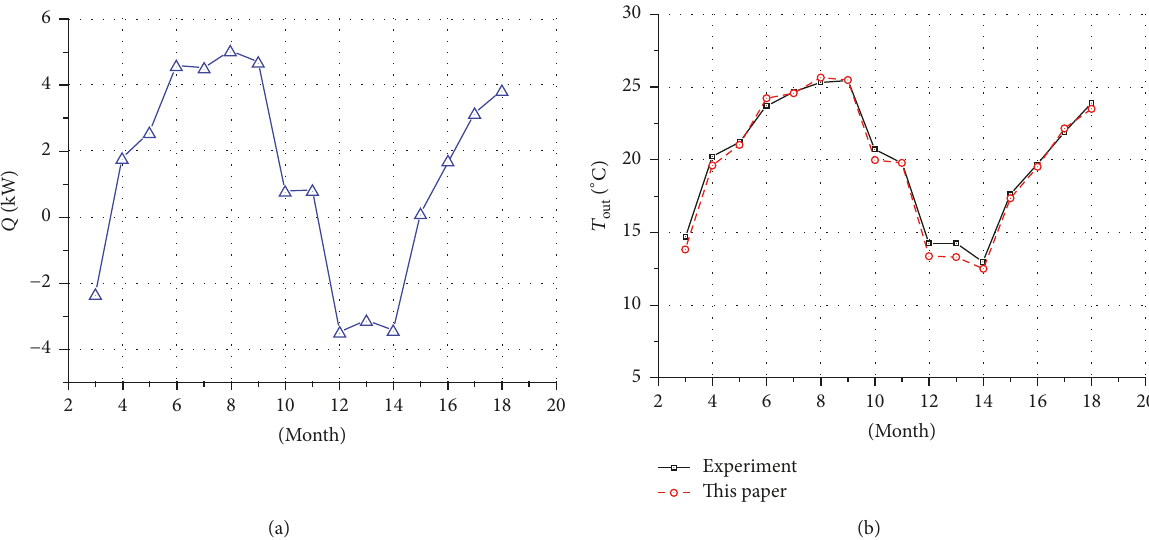
Figure 3: (a) Monthly average heat extraction/rejection rates; (b) comparison results of monthly average outlet fluid temperature [26].